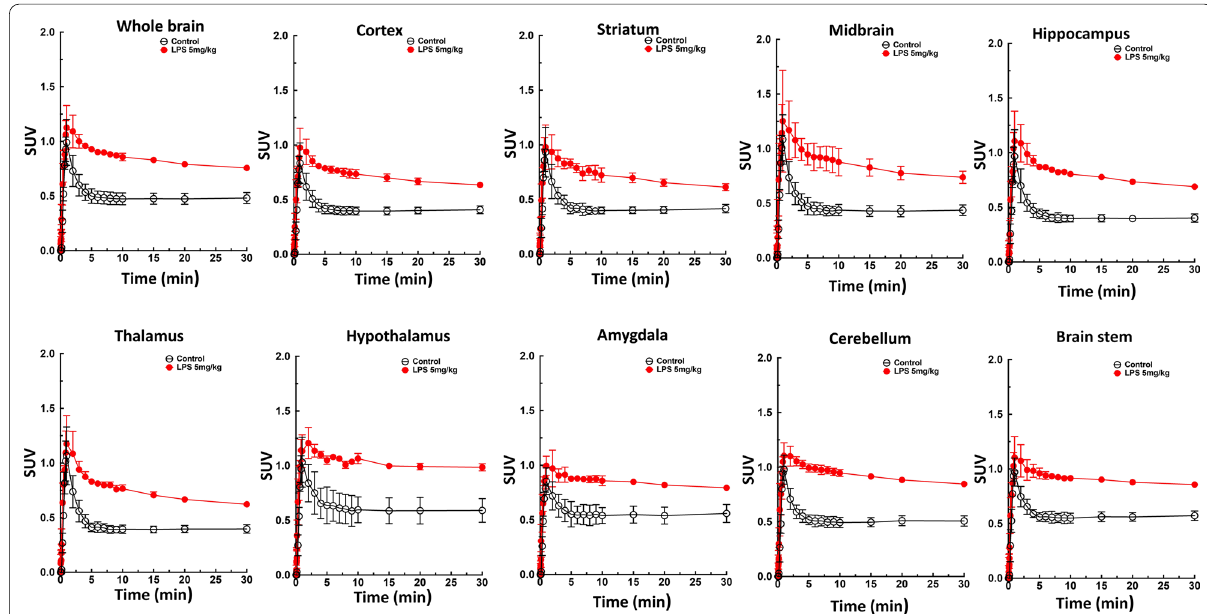
Fig. 4 Time‑activity curves for animal PET/MR studies of [ 18 F]FEPPA of the brain for the control group and 24 h after LPS injection (5 mg/ kg). Significantly higher [ 18 F]FEPPA uptake was observed in all brain regions of the LPS group at 24 h compared to the control group. Data are mean SEM of 6–8 mice per group ±